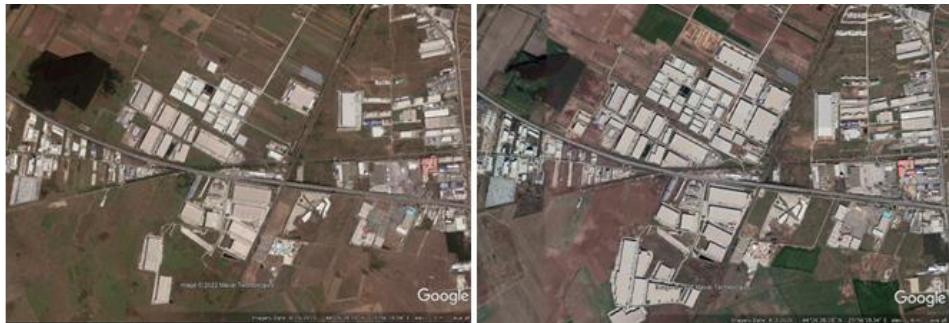
Figure 8. Expansion of the built- up space in Valea Lupului, Iaşi : 2017 ( left ) and 2020 ( right ).